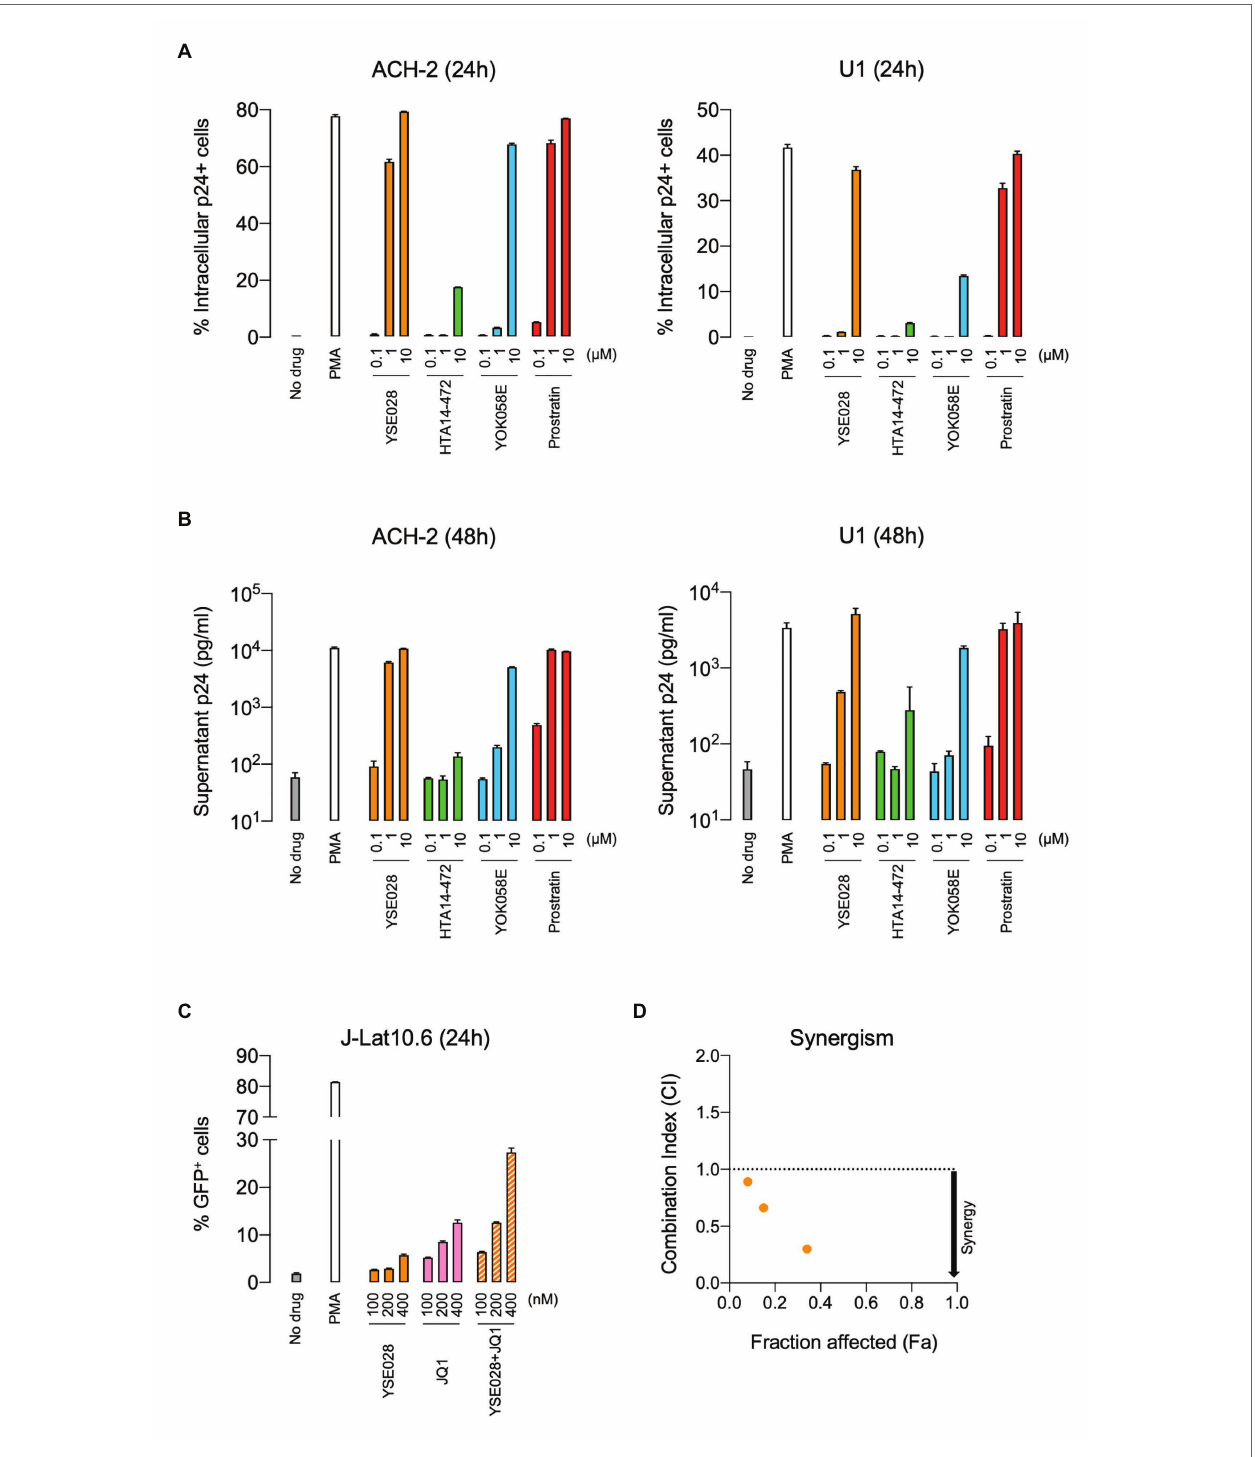
FIGURE 2 | Reversal of HIV-1 latency with DAG-lactone derivatives in vitro . ACH-2 and U1 cells were exposed to a DAG-lactone derivative and prostratin. The expression of intracellular HIV-1 p24 protein (A) and production of p24 in the supernatant (B) were measured after 24 and 48 h of incubation, respectively. (C) J-Lat 10.6 cells were exposed to different concentrations of YSE028 or JQ1 or a combination of both, and the change in the number of green fluorescent protein (GFP)-positive cells was analyzed after 24 h by flow cytometry. (D) Synergism in drug combinations was examined using CompuSyn software. Combination index (CI) values <1 indicate synergistic effects. Data are shown as means ± standard deviations of three independent